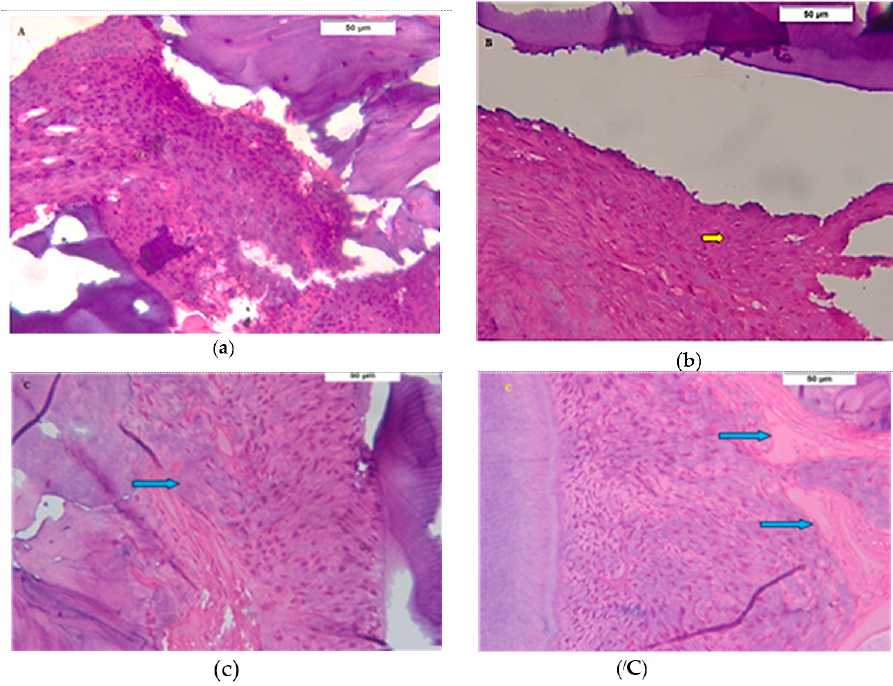
Figure 2. Two days interval. ( a ) Photomicrograph of the scaling and root planing (SRP) group showing numerous inflammatory cells infiltrating the periodontal ligament and disorganized bone trabeculae (H&E 400×); ( b ) Photomicrograph of the adipose-derived stem/stromal cell (ADSC) group showing numerous inflammatory cells infiltrating the periodontal tissues (yellow arrow) (H&E 400×); ( c ) Photomicrograph of the exosomes (Exo.) group showing a large periodontal ligament space filled with a disorganized proliferating periodontal ligament tissue (H&E 400×) and attached to a regular cementum surface. Osteoid tissue (blue arrows) is formed on the bone surface (H&E 400×) in ( /C ). After the two week interval, all groups show formation of new periodontal tissues with different degrees of proliferation and organization. In the SRP group, there were multiple large blood vessels in periodontal space, with less evidence of proliferating periodontal cells, while the newly formed bone trabeculae were disorganized with a layer of osteoid tissue (Figure 3a). In the ADSC group, the periodontal tissue was highly cellular and disorganized, while the alveolar bone showed multiple reversal lines with narrow spaces and a thick layer of osteoid tissues (Figure 3b). The Exo. group showed the most evident proliferation in periodontal tissue, with increased cellularity and significant organization, also, the alveolar bone was more organized with an osteoid tissue layer (Figure 3c,/C).